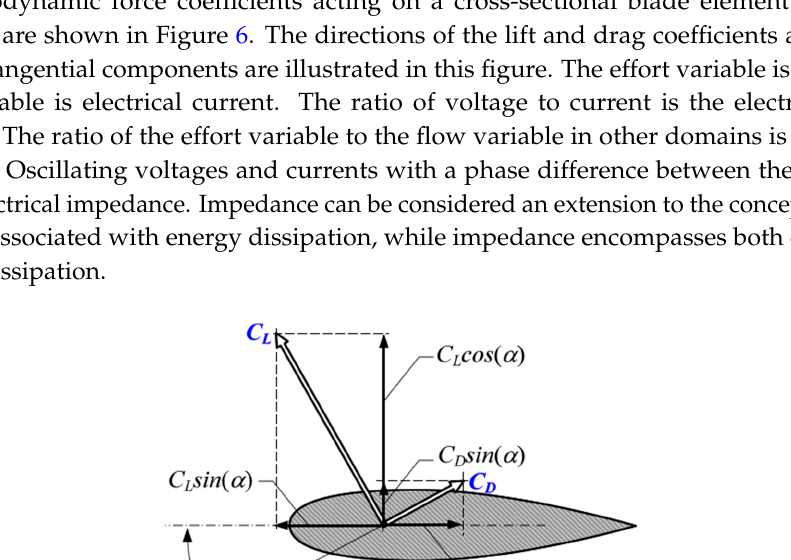
Figure 5. Electric circuit model for wind flow.